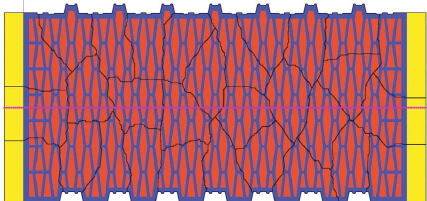
Figure 4: Domain decomposition of the ceramic block. The pink line marks the profile for comparison of